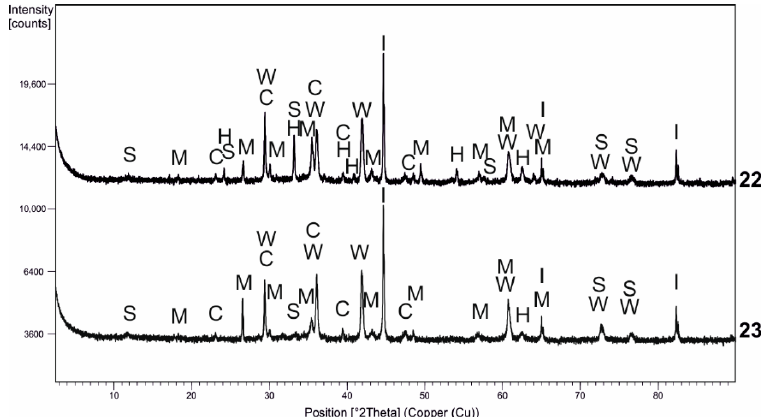
Figure 6. XRD pattern of sample No. 22 and 23. Symbol explanation: C — calcite, H — hematite, I — iron, M — magnetite, S — srebrodolskite. Minerals 2020 , 10 , x